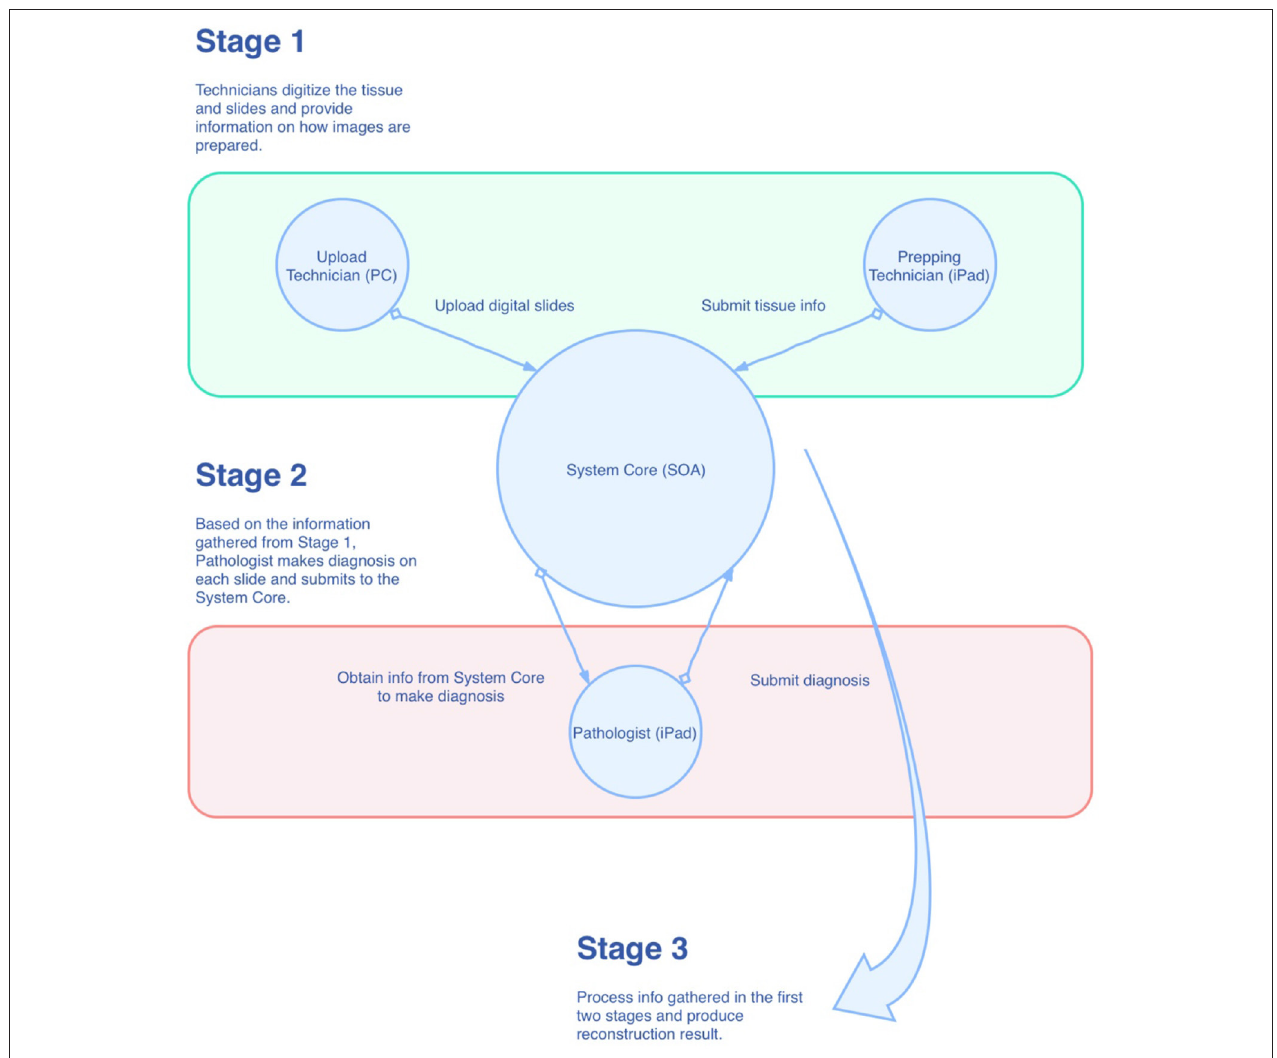
FIGURE 1 | Overview of the mapping